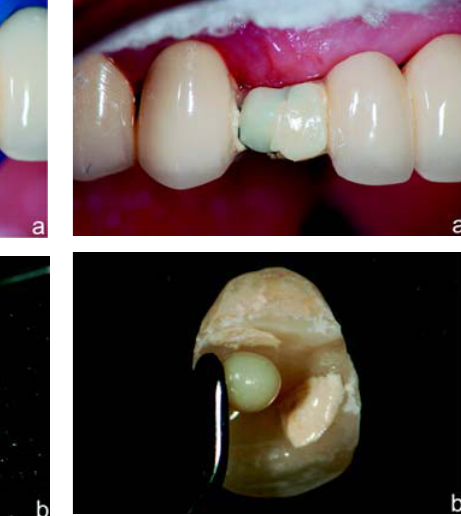
FIGURE 9- Initial aspect of the case with a dislodgement of the ceramic portion from the metallic structure in the maxillary right canine (a). View of the ceramic fragment (b)